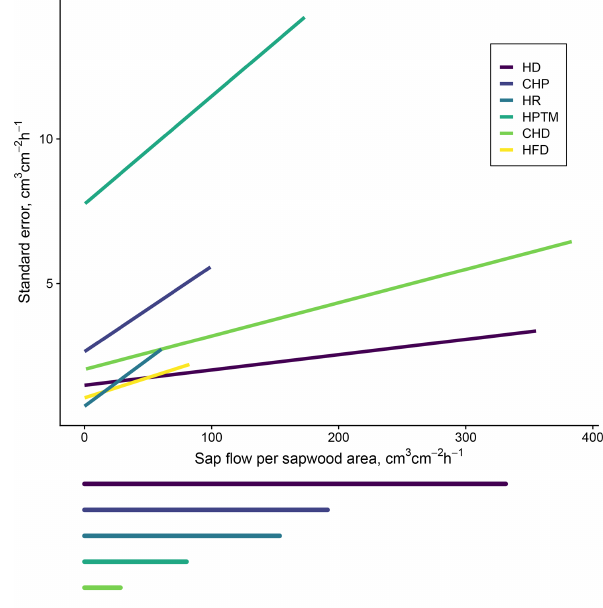
Figure B1. Methodological uncertainty estimation in sap flow den- sity measurements based on the data from the global meta-analysis of sap flow calibrations in Flo et al. (2019). The main panel shows predicted standard error based on method-specific linear mixed models of reference flow as a function of measured flow including the individual calibration as a random intercept factor. The span of the horizontal lines below the main panel corresponds to the max- imum sap flow density in SAPFLUXNET (estimated as the 99% quantile of sub-daily measurements) for that specific method.